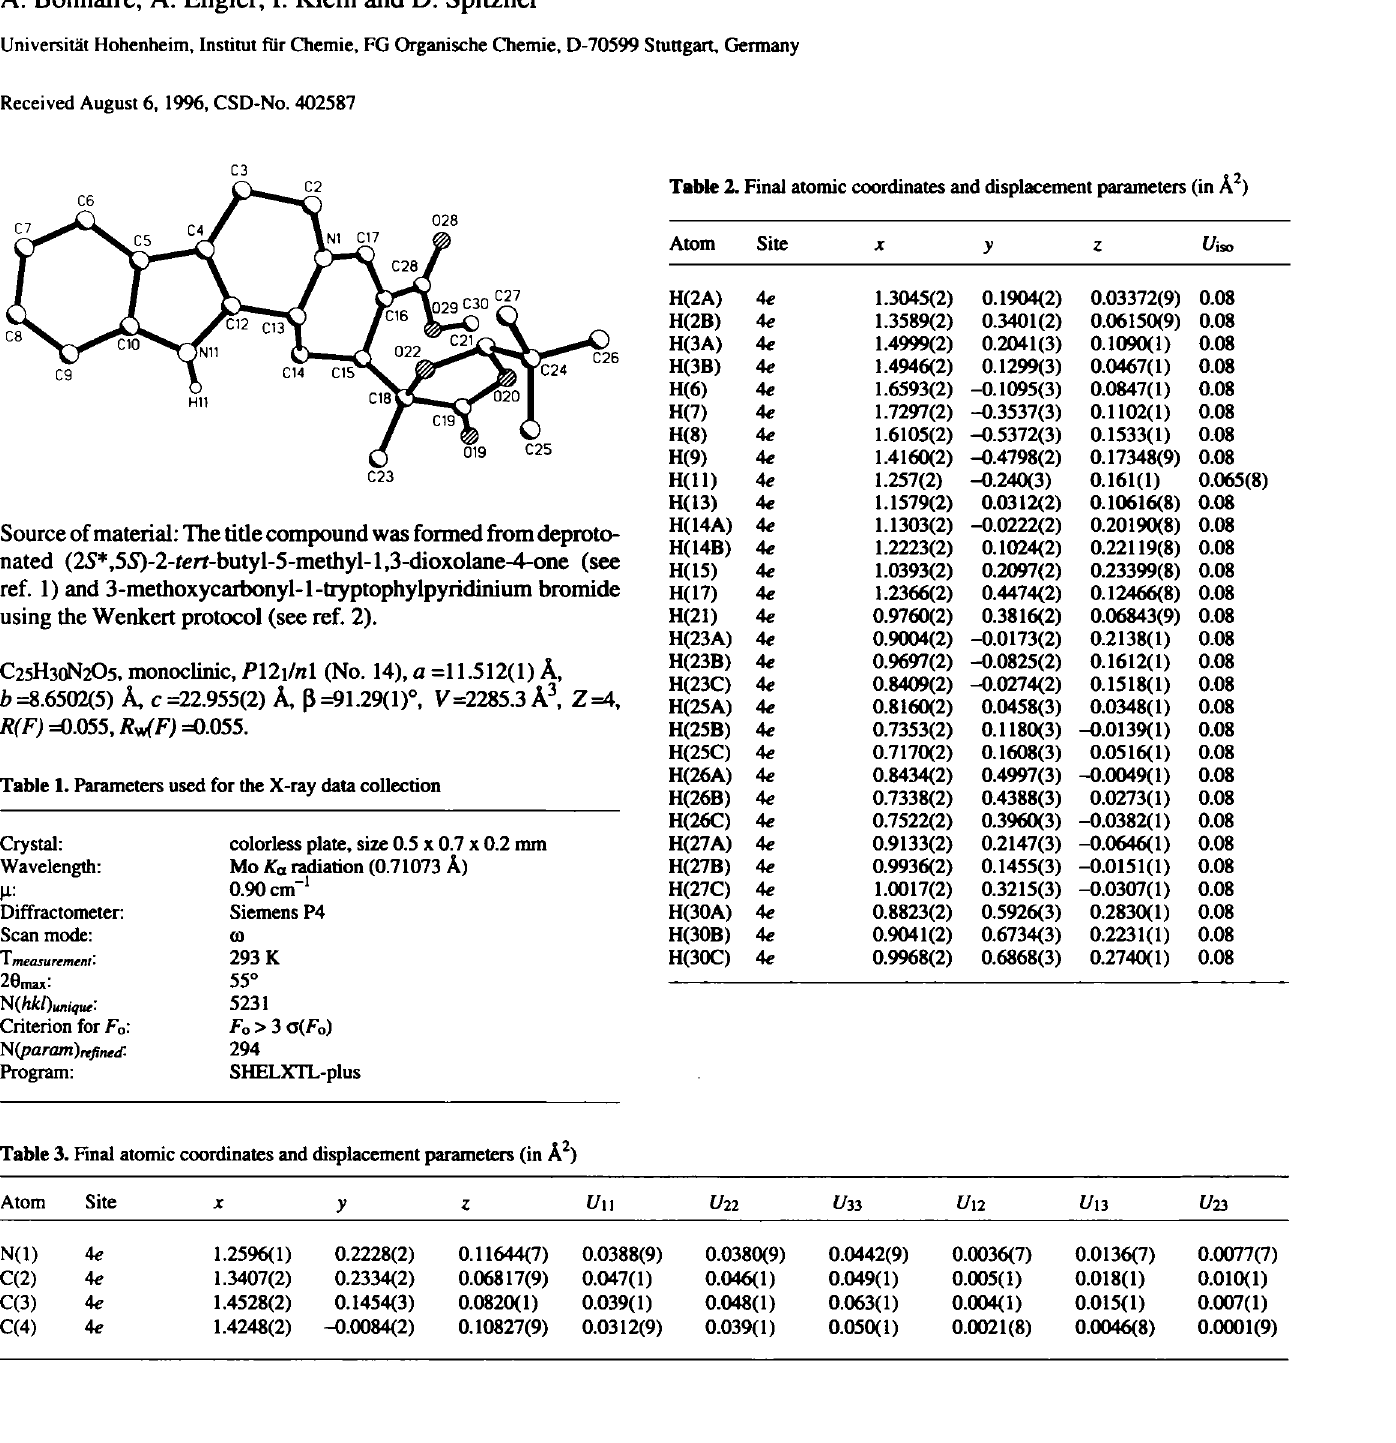
Table 2. Final atomic coordinates and displacement parameters (in Â 2 )